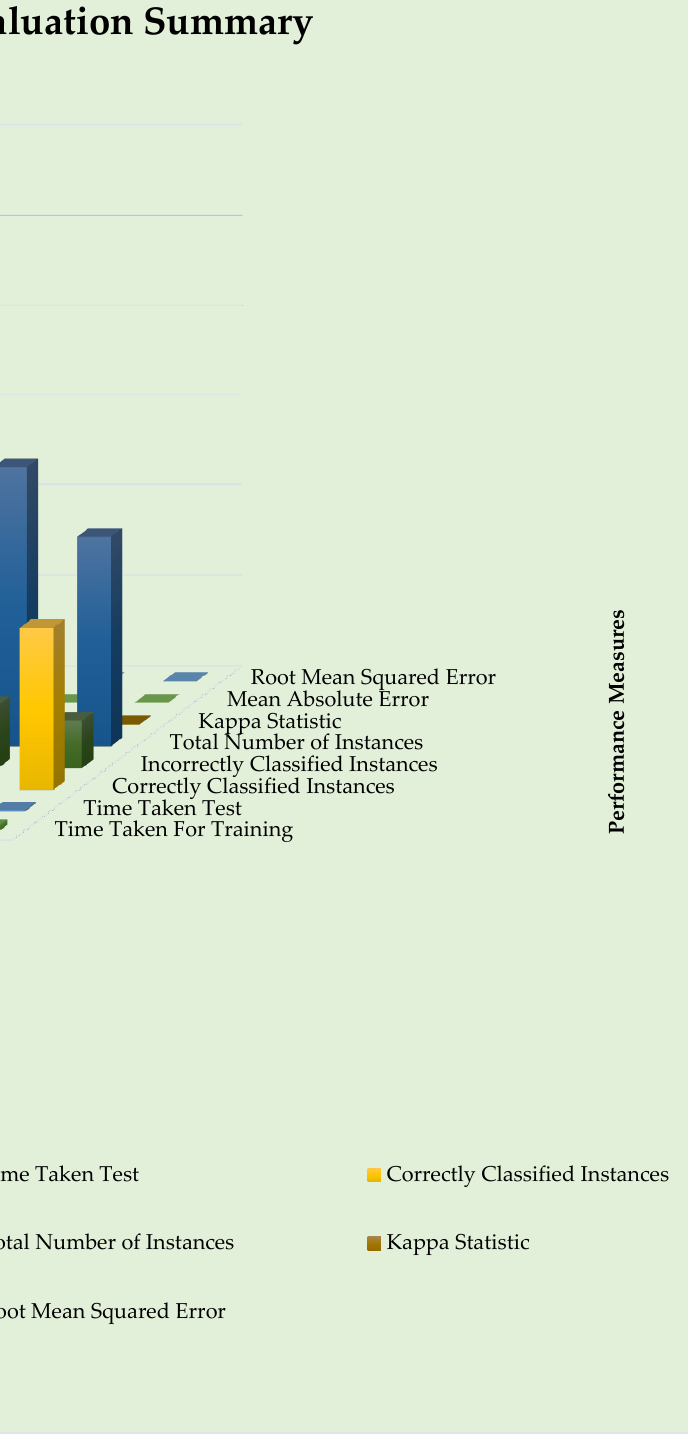
Figure 8. Graphical representation of evaluation on split test (tetrad feature selection techniques). Table 8 represents the precise accuracy by class using the tetrad of feature selection technique in combination with LL, and its graphical representation is shown in Figure 9. Table 8. Detailed accuracy by class (tetrad feature selection techniques).